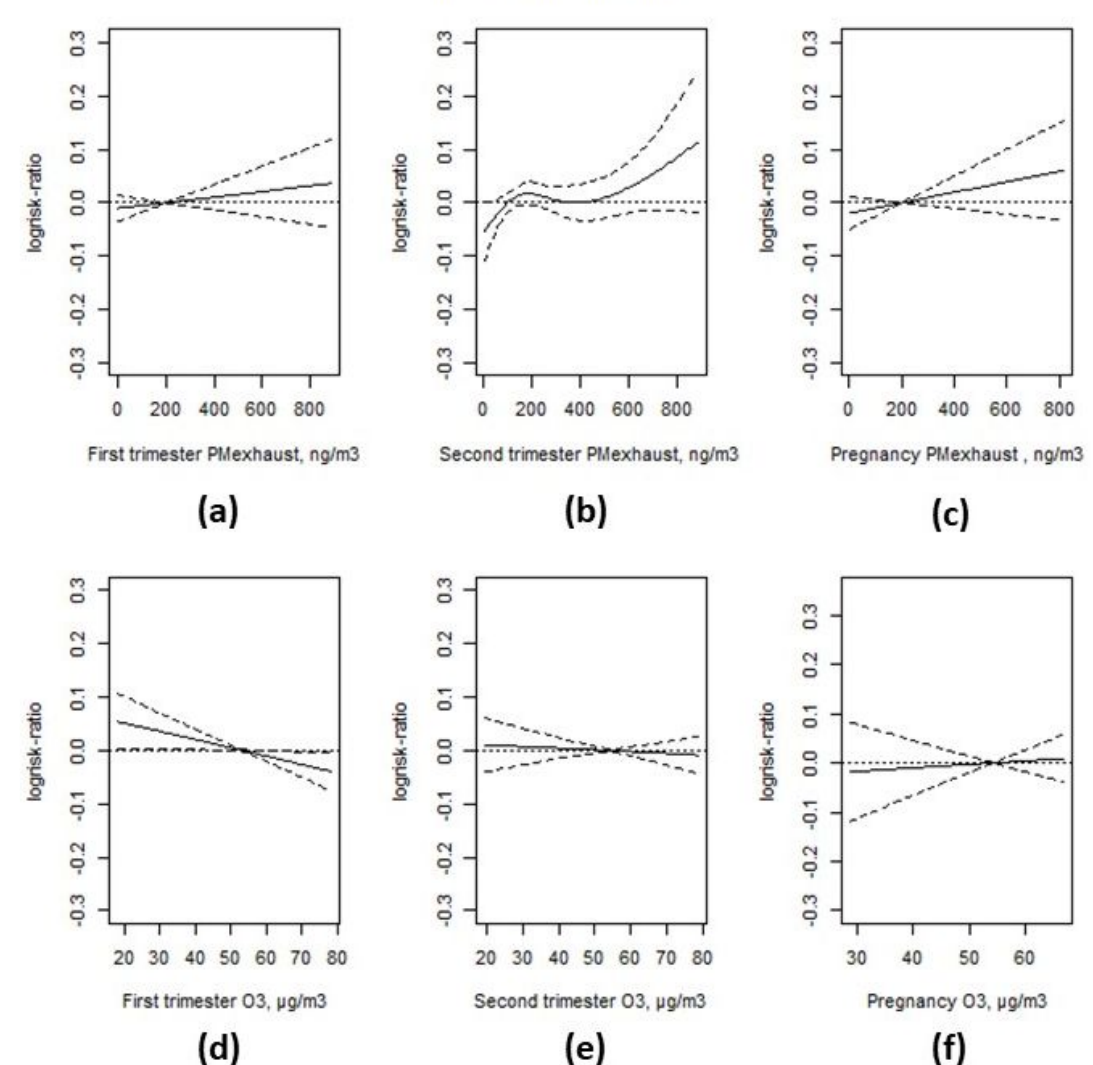
Figure 3. Associations between PM-exhaust ( a – c ), ozone (O 3 ) ( d – f ) during di ff erent stages of gestation and SGA from two-pollutant models. All models were adjusted for maternal and paternal level of education, family income, area level income and education, family situation, parity, maternal smoking habits, body mass index (BMI) at first antenatal visit, maternal region of origin, maternal age at delivery, and conception date.